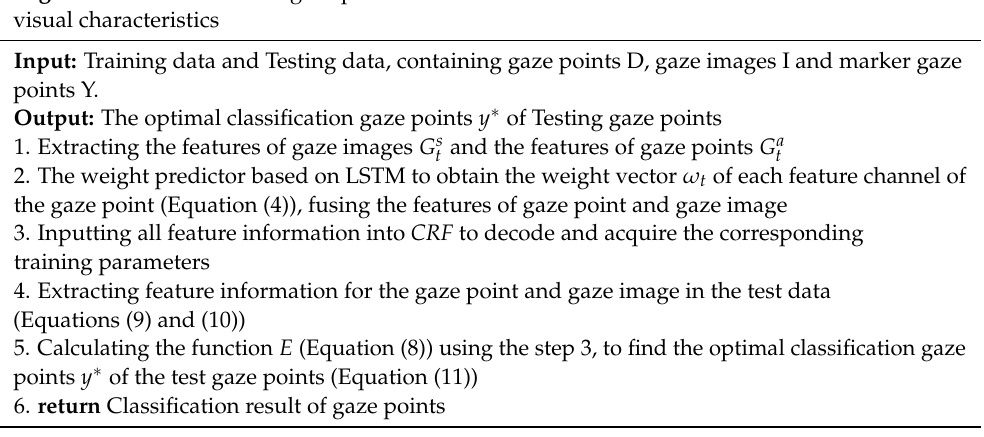
Algorithm 1: A method for gaze point classification based on conditional random field and visual